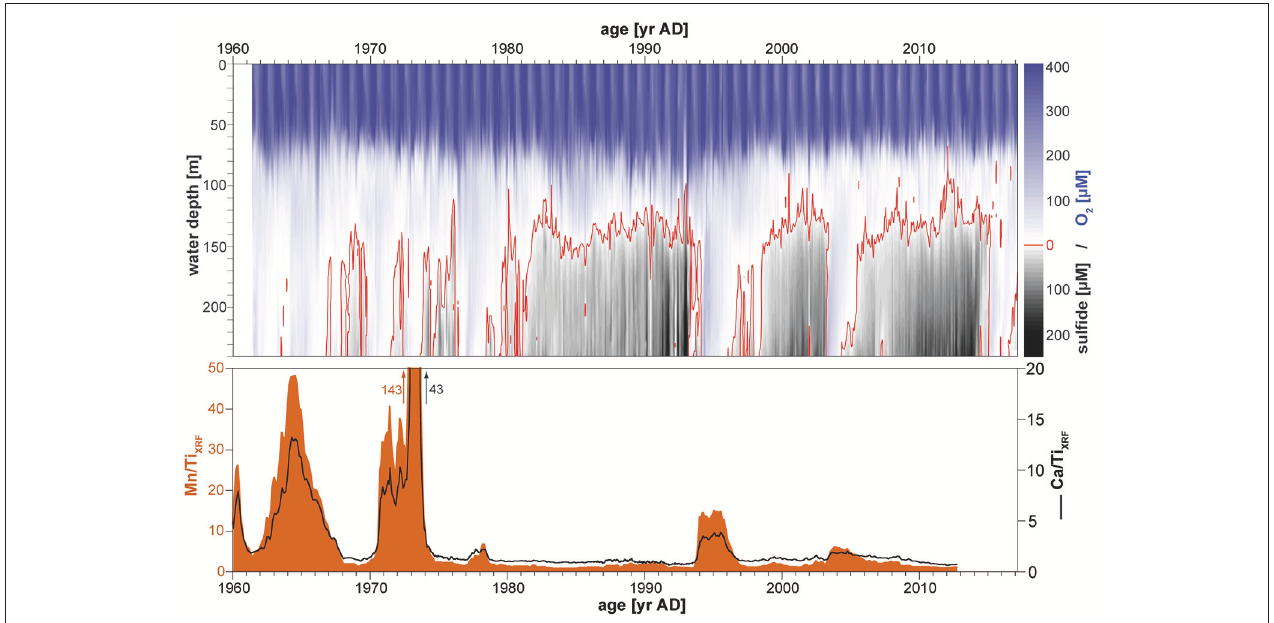
FIGURE 9 | Comparison of the instrumental time series of O 2 and total sulfide in the water column of the Gotland Deep at site 271 from 1960 to 2017 (ICES, 2015) with Mn/Ti and Ca/Ti ratios from X-ray fluorescence core scanning of a dated short core taken in August 2012.